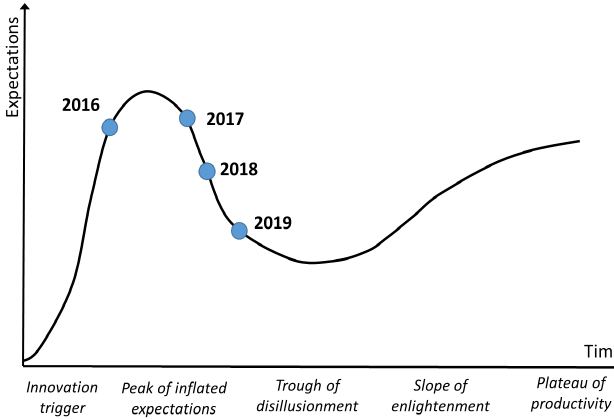
Figure 2 . Approximate positions for blockchain technology along the Gartner Hype Cycle for emerging technologies,